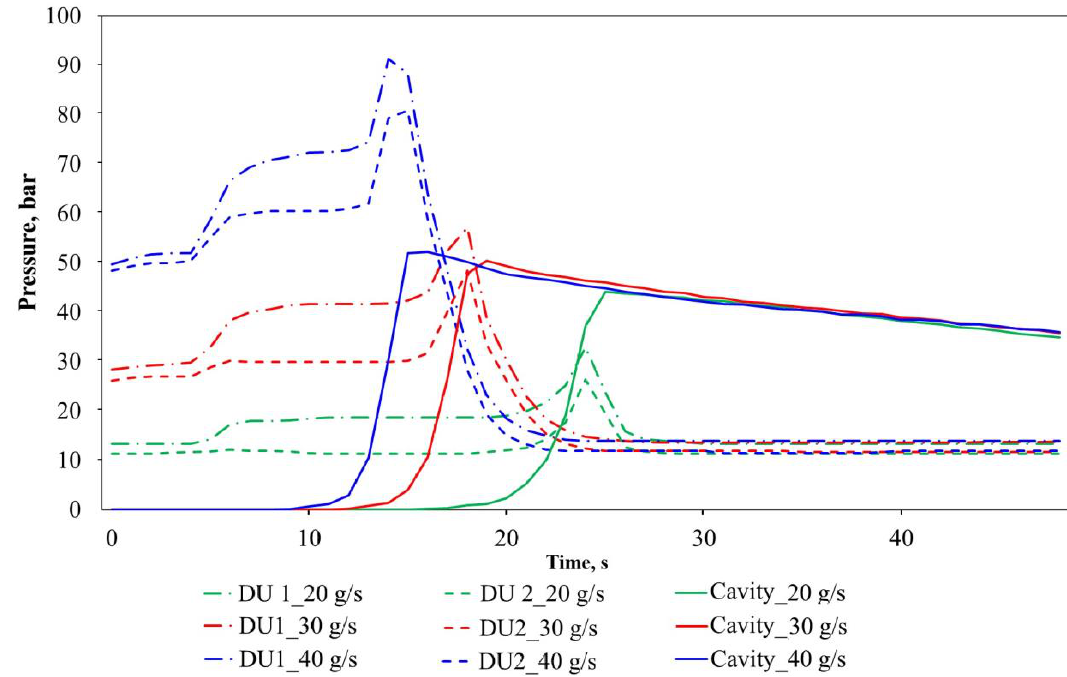
Figure 10. The pressure curves of the neat PA-6 during the T-RTM process (DU1 and DU2 are dosing unit 1 and dosing unit 2, respectively).